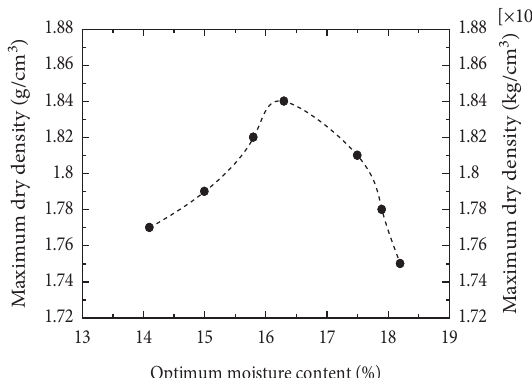
Figure 6: Compaction characteristics of lateritic soil sample [13].